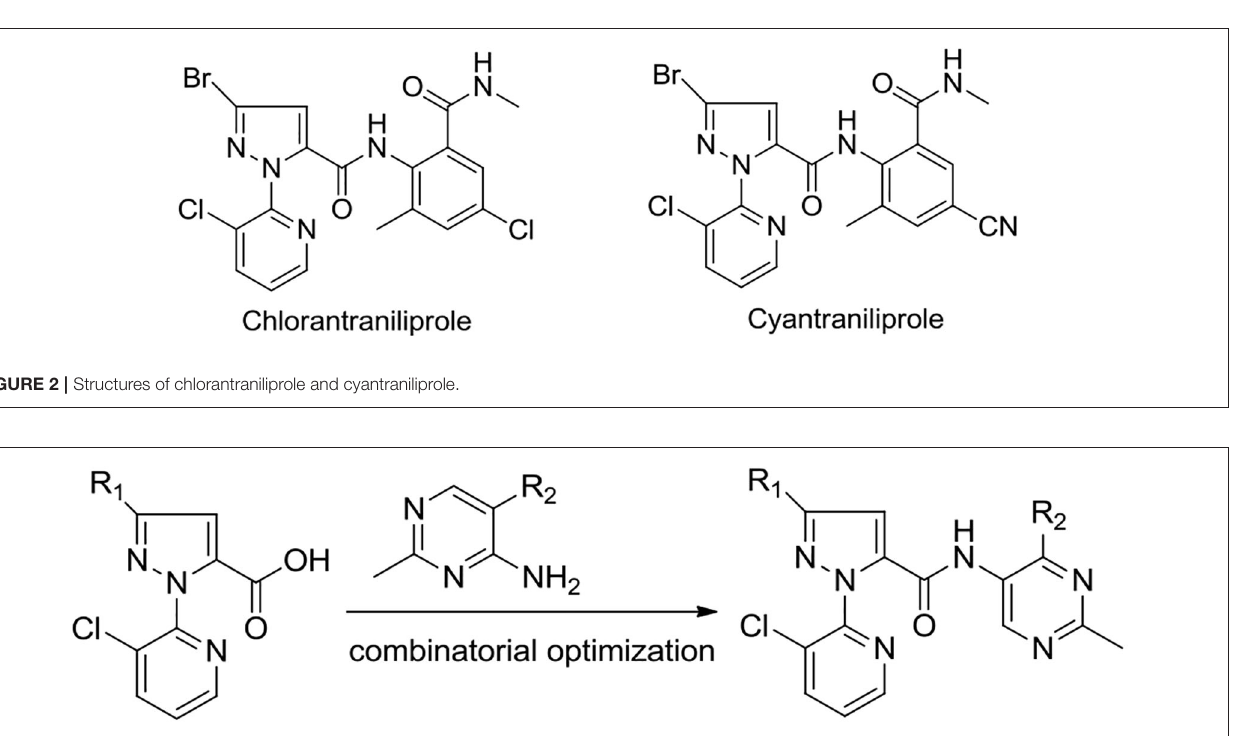
FIGURE 3 | Design strategy for title compounds 6a – 6m